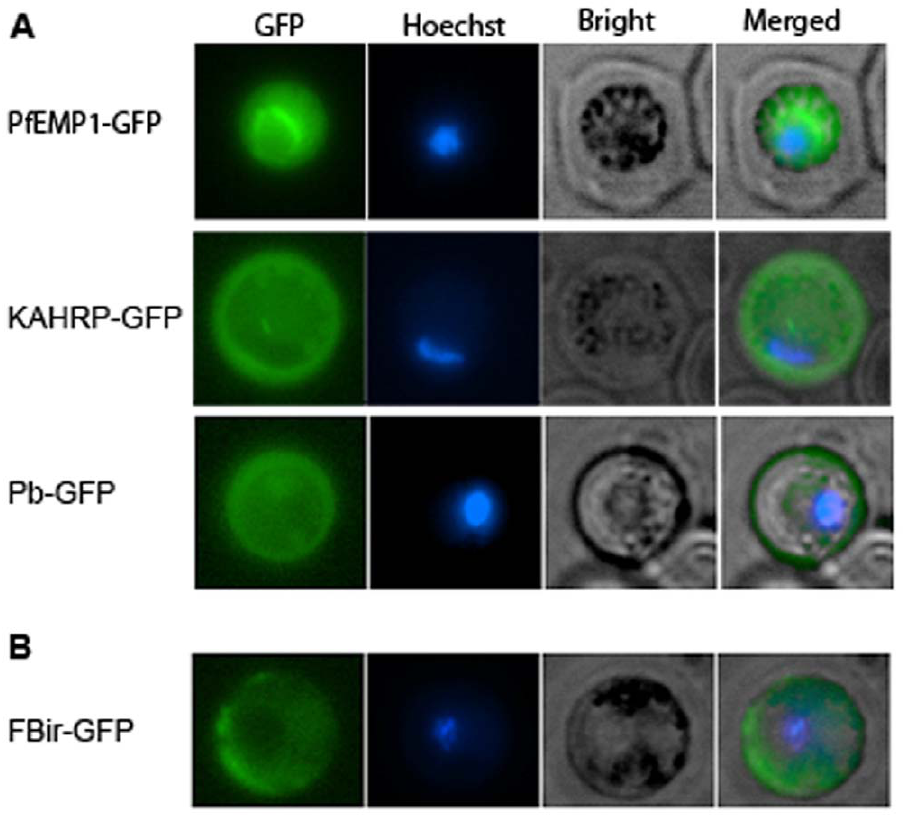
Figure 2. N-termini with a signal/hydrophobic sequence preceding the PEXEL/VTS motif exported GFP. ( A ) GFP reporters with the N- terminus of PfEMP1 (PfEMP1-GFP), KAHRP (KAHRP-GFP), and a predicted P. berghei exported protein (Pb-GFP) were expressed in P. berghei , and live parasites were stained with the DNA labeling dye Hoechst and viewed under an epifluorescence microscope. The expression of GFP, staining of the parasite nucleus (Hoechst), bright field images, and merged images are shown for representative trophozoite-stage parasites. ( B ) A GFP chimera of a flag-tagged P. berghei variant antigen bir (Fbir-GFP), which lacks the PEXEL/VTS motif, was expressed in P. berghei , and live trophozoite-stage parasites were imaged as described above.